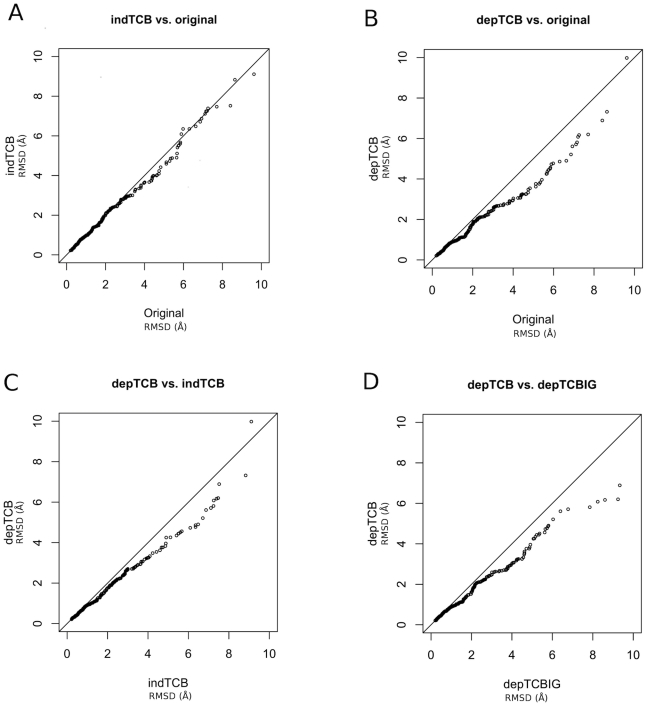
Quantile-quantile (QQ) plots for 230 loop predictions by Rosetta using different Ramchandran distributions.Each figure plots the numerically sorted Cα RMSDs for predictions from one form of Ramachandran distributions against the numerically sorted Cα RMSDs from another. A: neighbor-independent TCB distributions vs. original distributions in Rosetta; B: neighbor-dependent TCB distributions vs Rosetta original distributions; C: neighbor-dependent TCB distributions vs neighbor-independent TCB distributions; D: neighbor-dependent TCB distributions vs neighbor-dependent TCBIG distributions.